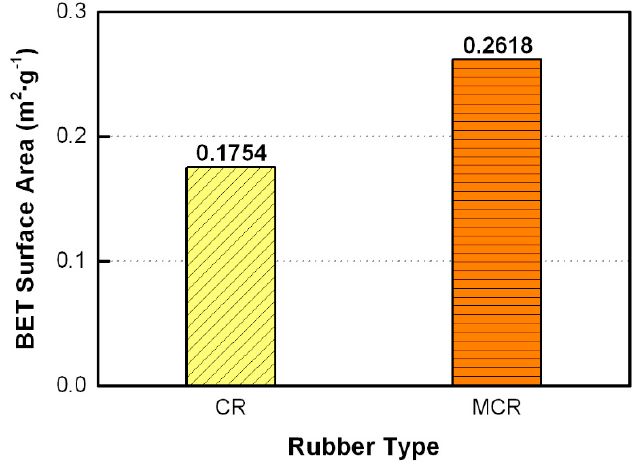
Figure 3. BET test results of normal rubber and modified rubber.